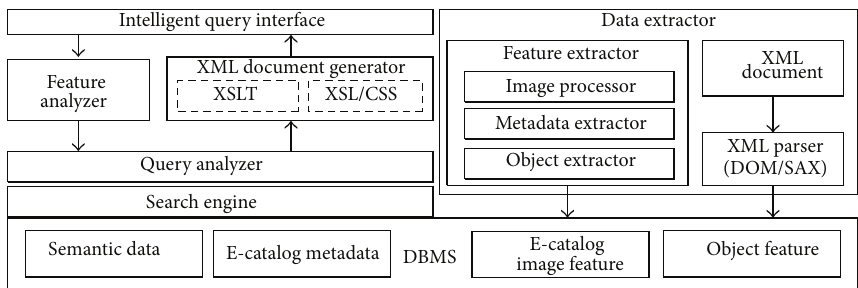
Figure 2: Platform architecture of the